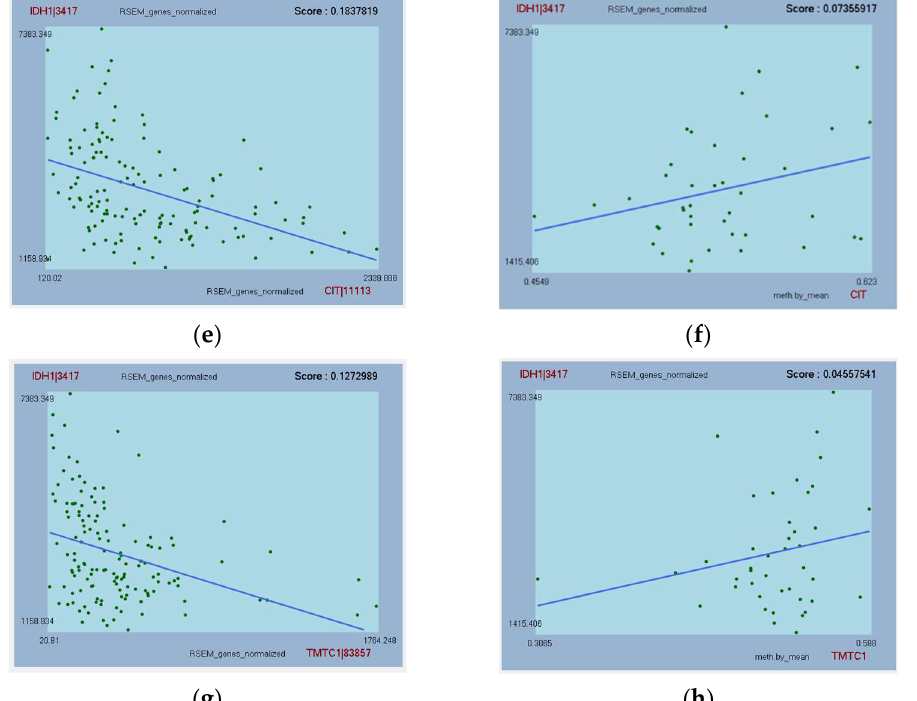
Figure 3. Correlations of IDH1 gene expression with expression and methylation data for TSPYL2 ( a ) and TSPYL1* ( b ); JAKMIP1 ( c , d ); CIT ( e , f ); and TMTC1 ( g , h ). The linear regression line is provided as well as the R-squared “Score”. Parentheses indicate that transformed data (natural logarithm (l), arcsine (a), or square root (s)) provided a higher correlation in ACE. * Methylation data were not available for TSPYL2 in TCGA-GBM dataset, so TSPYL1 is presented instead.